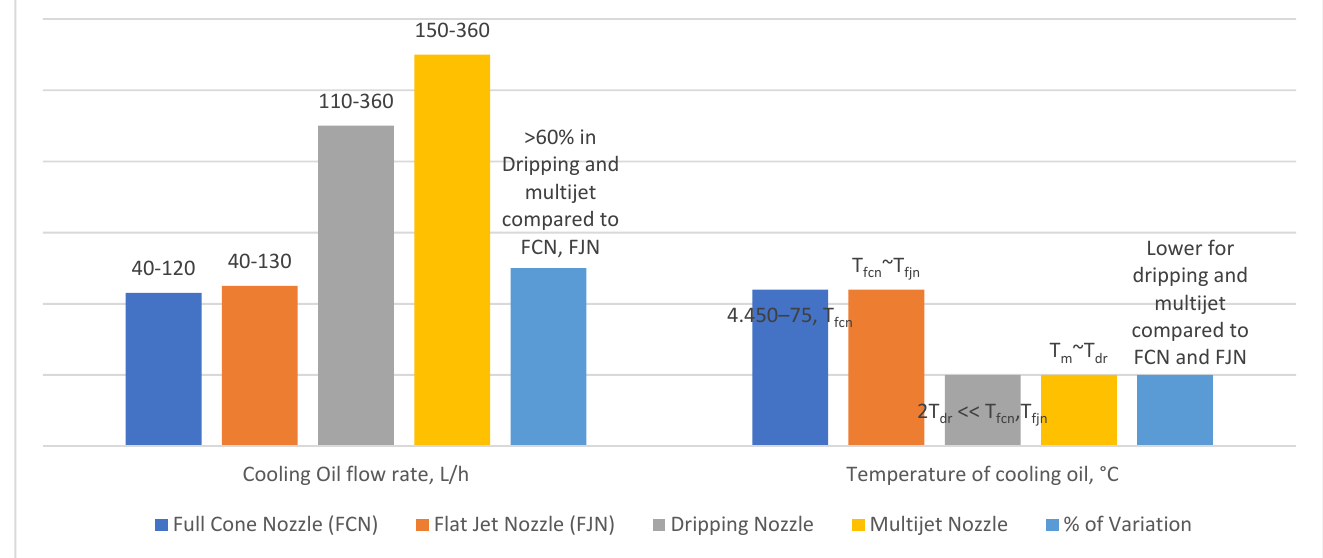
Figure 12. Experimental testing conditions [44].